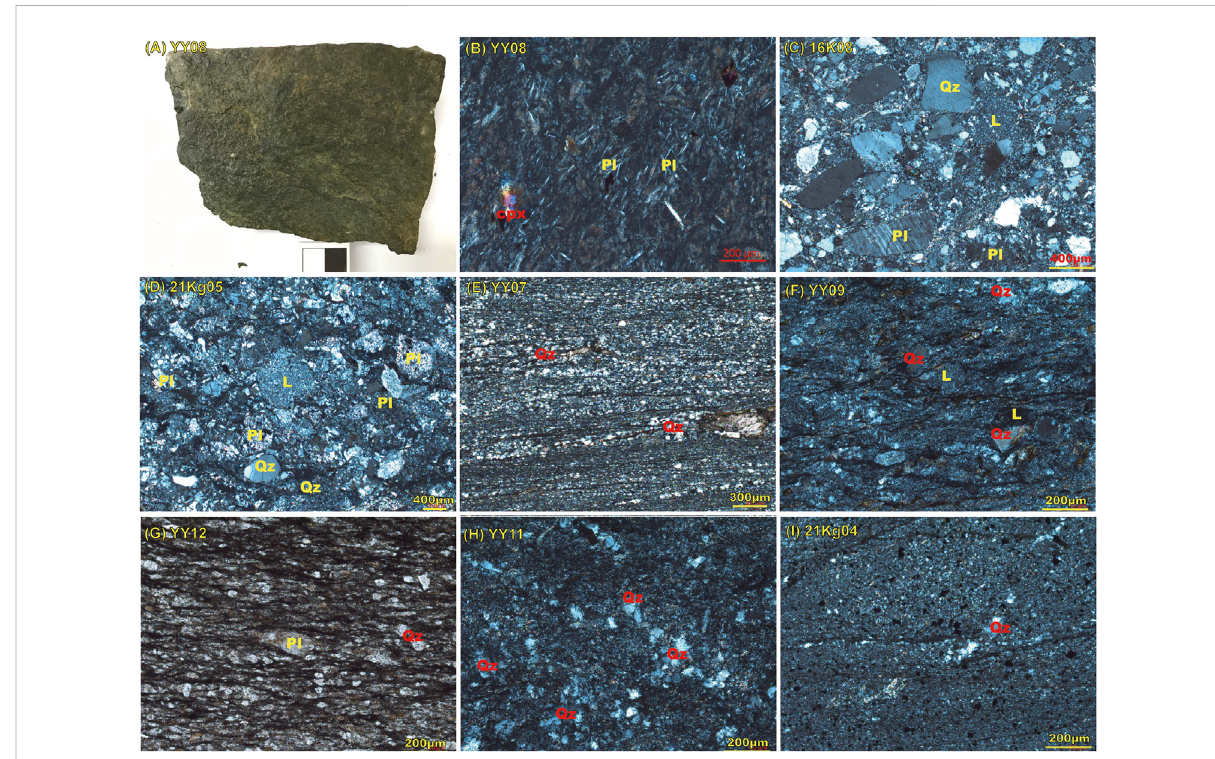
FIGURE 4 Photographs and Microphotographs of dated the samples. (A) Photographs of the basaltic sample YY08, (B) Microphotographs of the basaltic sample YY08, showing it comprises the clinopyroxene phenocrysts and plagioclase. (C,D) Microphotographs of coarse-grained sandstones (16K08 and 21Kg05), showing directionally, poor sorting and high proportions of detrital altered matrix. Grains are angular and subrounded. (E – G) Microphotographs of sandstones, showing directionally and poor sorting, high proportions of detrital and diagenetically altered matrix and a